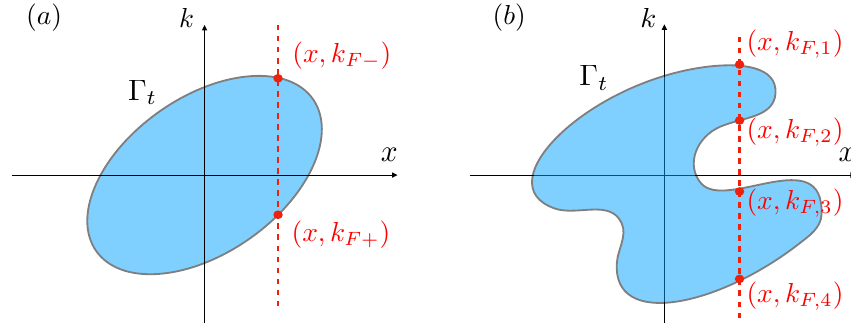
Figure 1: The curve Γ encircling the points ( x , k ) at which the Wigner function t n ( x , k , t ) is equal to one. Panel (a): the simple situation considered in this paper, where at any given position x there are only two Fermi points on the contour Γ , labeled as k . Panel (b): the general situation with more than two Fermi points, F ± not considered in this